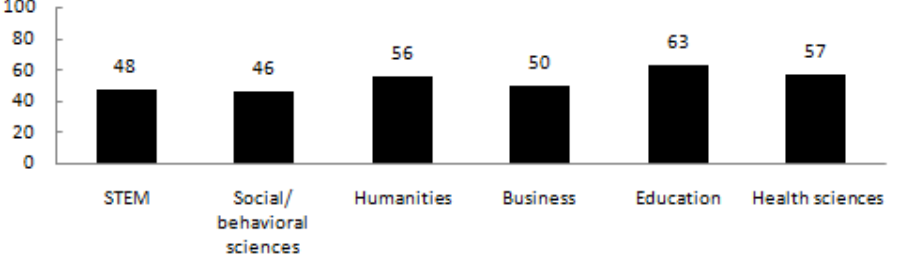
Figure 3. Atriton rates in STEM and selected non-STEM